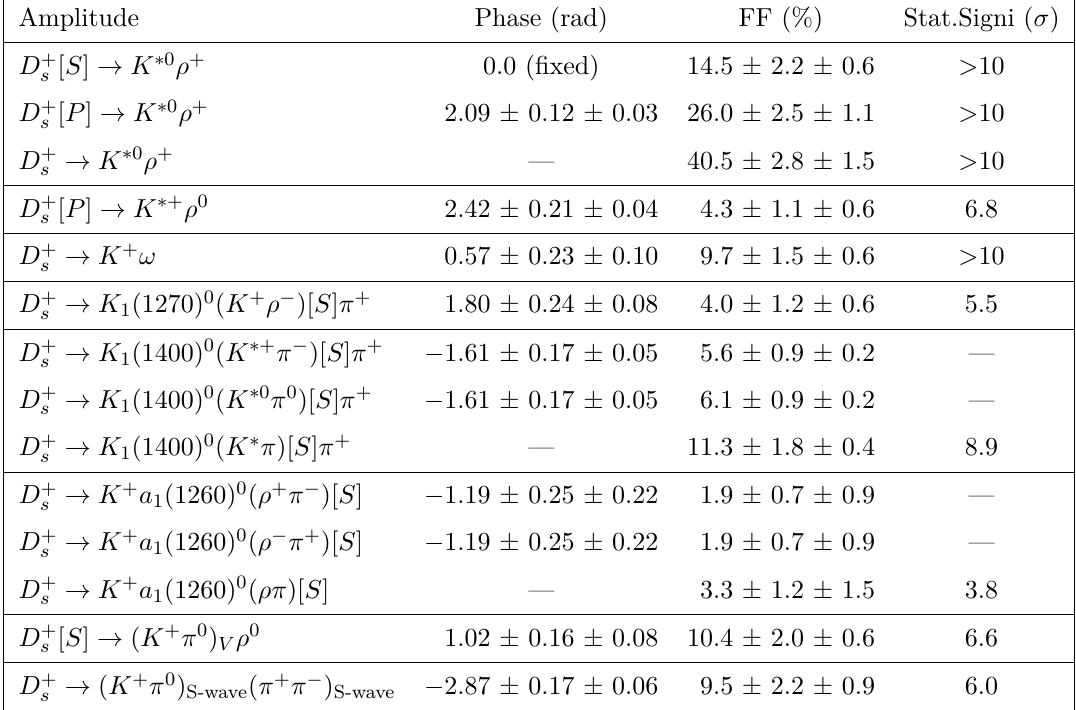
(1400) 0 and a (1260) 0 1 1